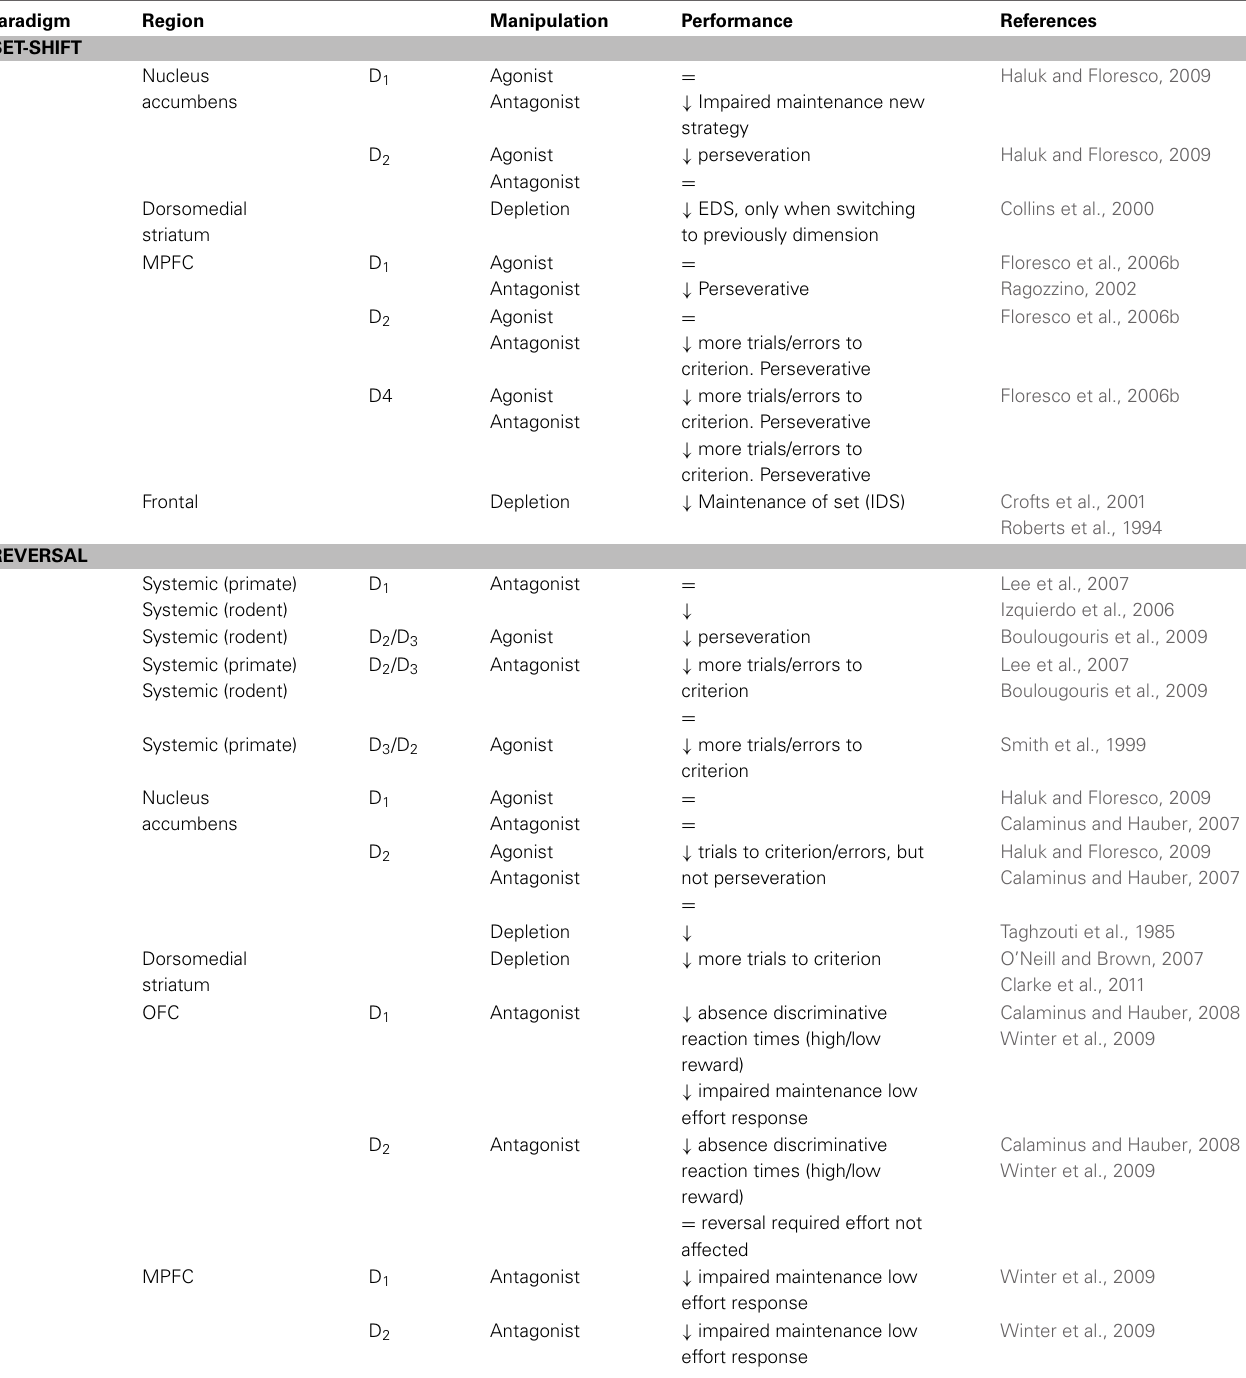
Table 2 | Summary of effects of pharmacological manipulations to the dopamine system on cognitive flexibility in animals.